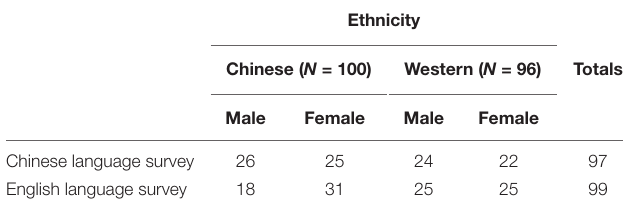
TABLE 1 | Sample language characteristics and